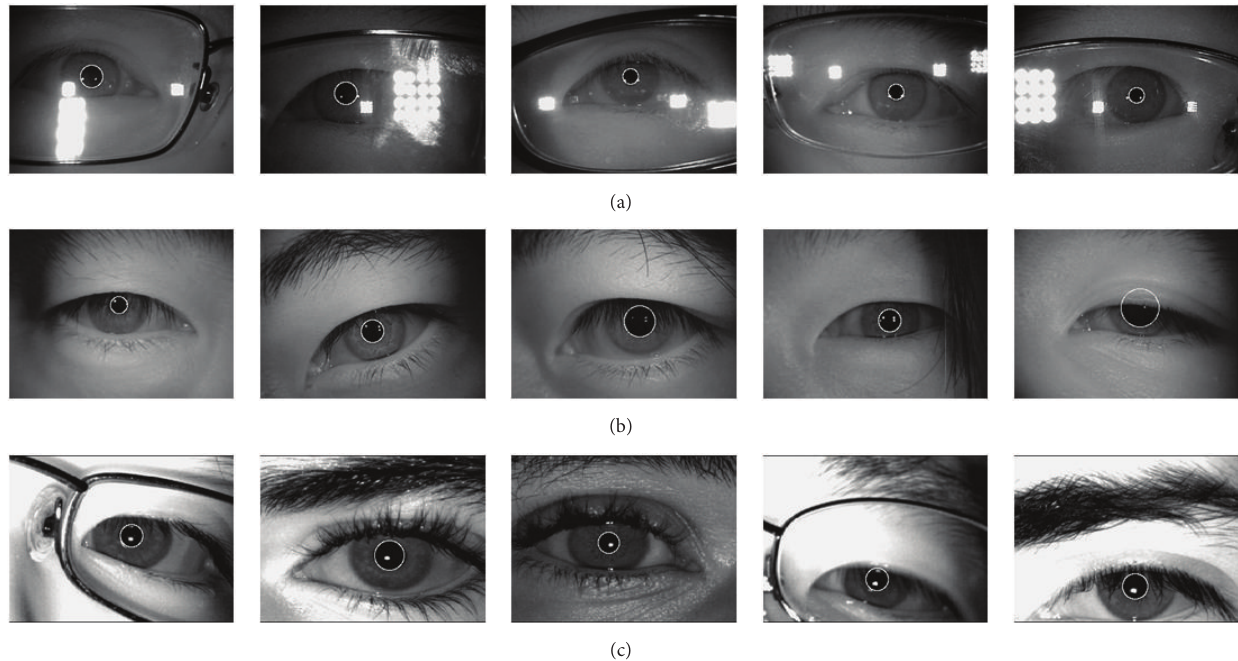
Figure 4: Accurately localized pupils in the iris images from three databases: (a) CITHV4, (b) CILV3, and (c)